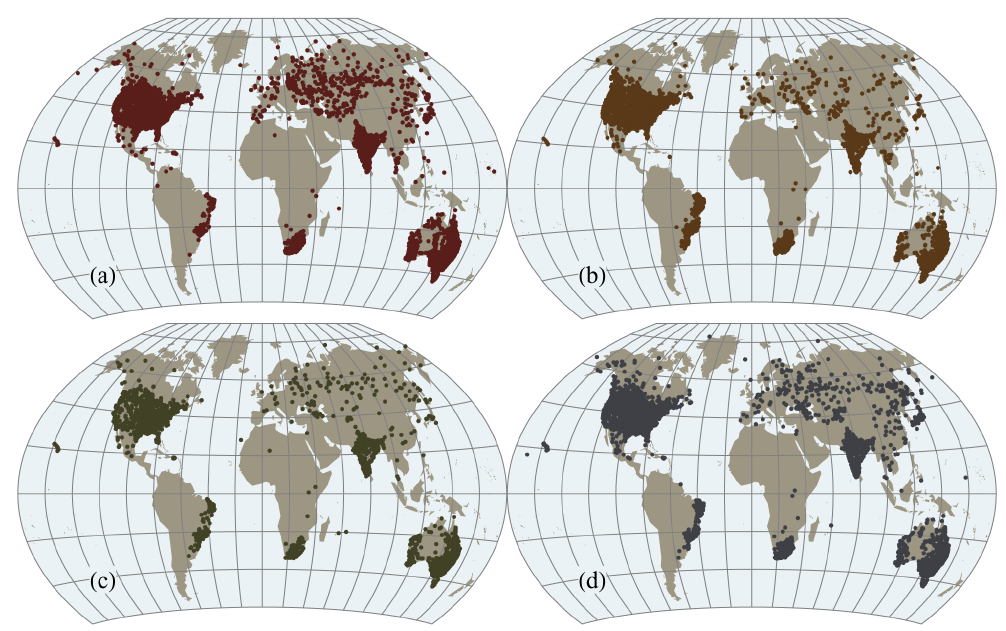
Fig. 7. Geographical depiction of the 15029 stations where the best fitted tail is (a) Pareto in 4621, (b) Lognormal in 4486, (c) Weibull in 2051, and (d) Gamma in 3871.